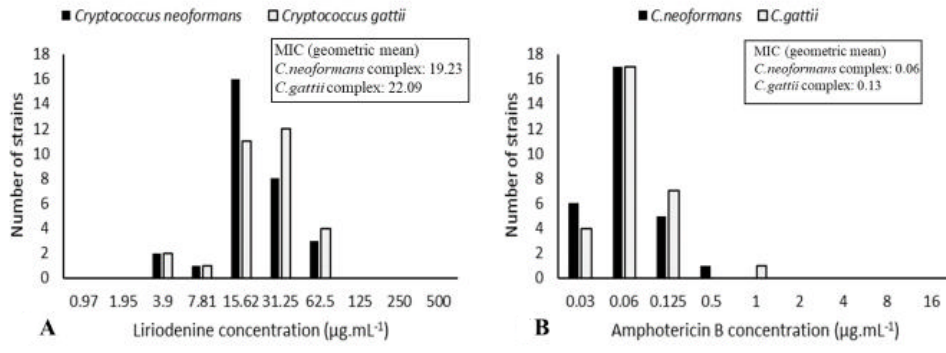
Figure 1. Minimum inhibitory concentrations (MICs) of liriodenine (LRD) and amphotericin B (AmB) for 30 strains of the Cryptococcus neoformans complex and 30 strains of the Cryptococcus gattii complex, determined by broth microdilution method. Results as median and interquartile intervals, as well as geometric mean. The Mann-Whitney U rank test. Comparison of MICs as to Cryptococcus complex, (A) LRD: C. neoformans : 15.62 [15.62; 31.25], C. gattii : 31.25 [15.62; 31.25], p = 0.30; (B) AmB: C. neoformans : 0.6 [0.06; 0.06], C. gattii : 0.06 [0.06; 0.13], p =